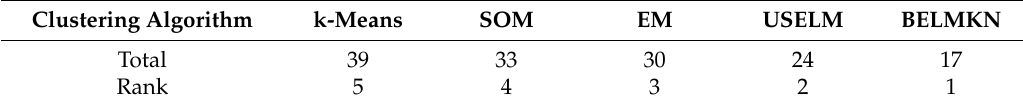
Table 5. The sum of ranking of the techniques and general ranking based on total ranking. Clustering